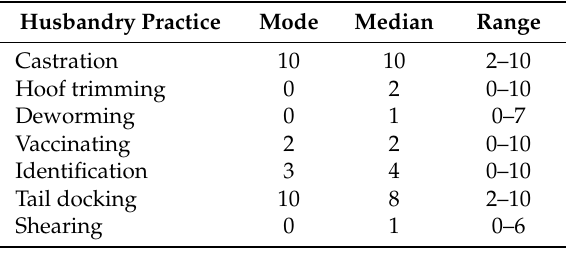
Table 2. Summary statistics of sheep farmers’ ( n = 125) perceptions of pain intensity associated to seven